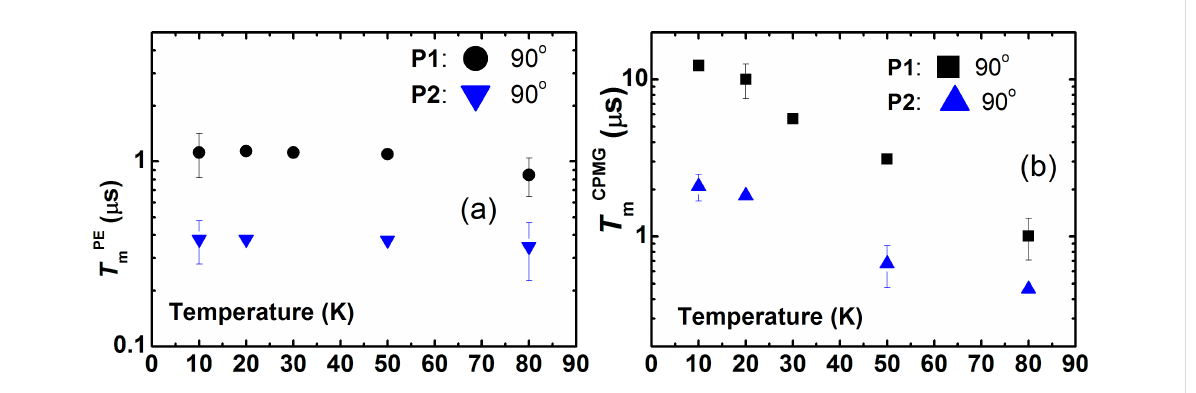
Figure 6: Temperature dependence of the phase relaxation time T m of P1 and P2 at a frequency ν = 33.9 GHz for the 90° field orientation measured with the primary echo sequence (a) and with the CPMG pulse sequence (b).